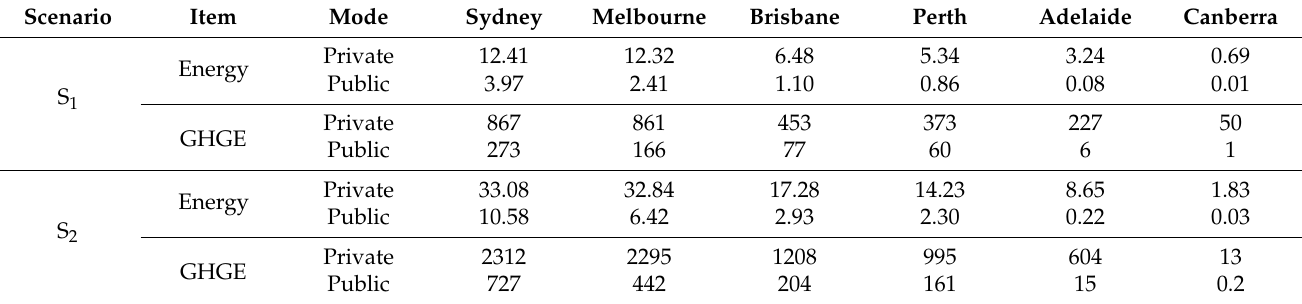
Table A5. Annual transport energy consumption (PJ) and daily GHGE (MtCO 2 -e d − 1 ) by employed people.